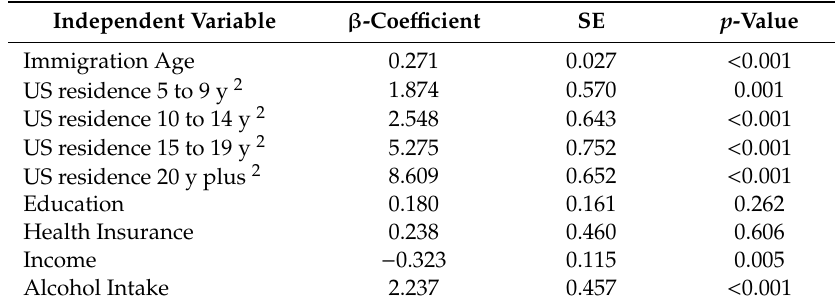
Table 4. Multiple Regression with CVD-Risk as the Dependent Variable in the Immigration-Age ≥ 20 y Group. Adjusted R 2 : 41% ( n = 368) 1